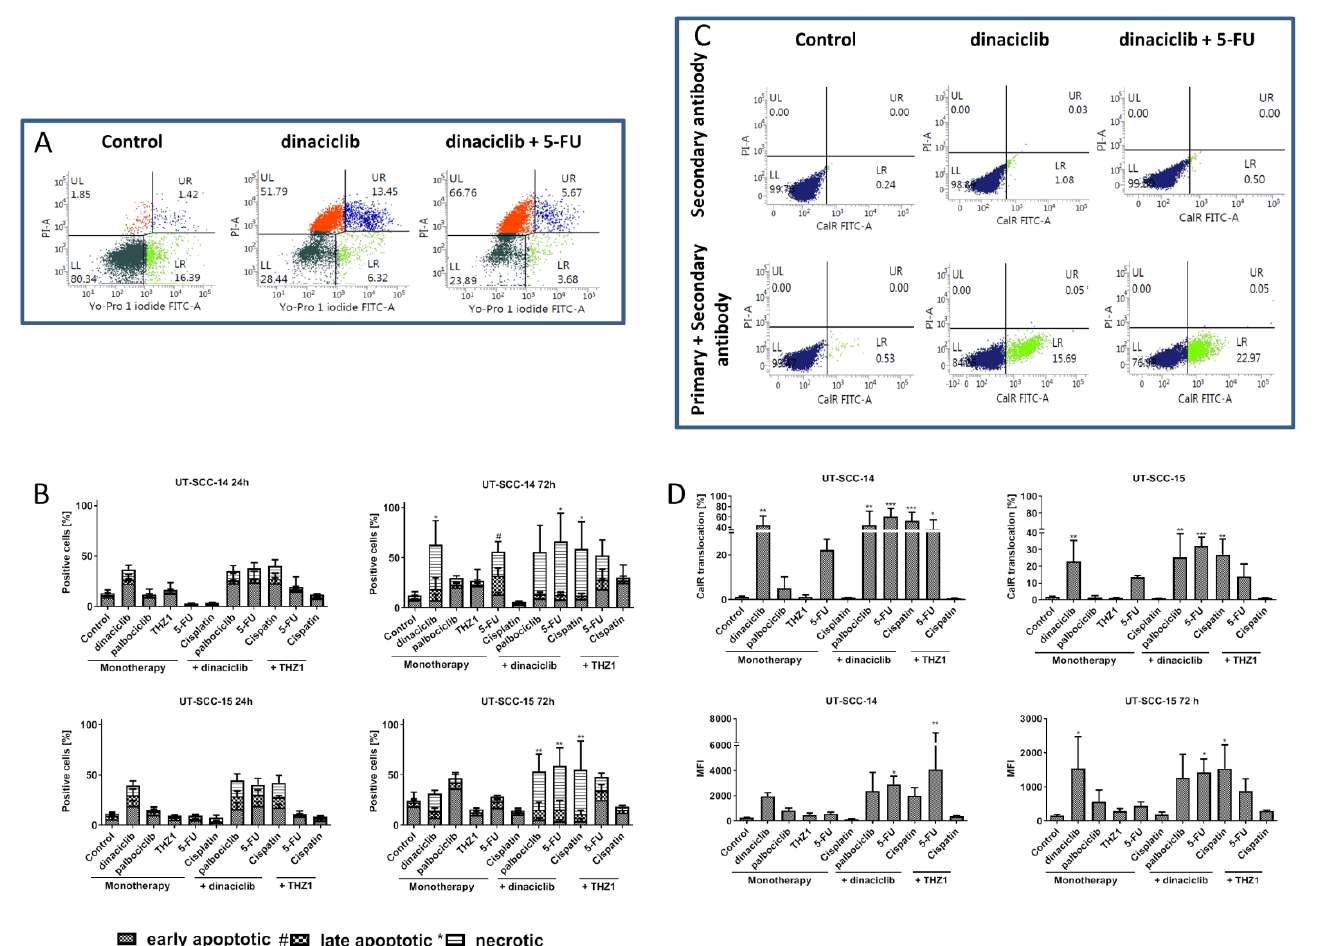
Figure 2. Apoptosis/necrosis assay and detection of immunogenic cell death (ICD). For ( A , B ) apoptosis/necrosis assay, cells were stained with Yo-Pro 1 iodide and PI. Cells that were positive for Yo-Pro 1 iodide were defined as early apoptotic, cells that were positive for PI were defined as necrotic, and double positive cells were defined as late apoptotic. Apopto- sis/necrosis assay was done after 24 h and 72 h. ( A ) Representative dots plots showing distribution of viable and dead cells (either apoptotic or necrotic). ( B ) Quantitative analysis of apoptotic and necrotic cells subdivided into early apoptotic (Yo-Pro1 + /PI − ), late apoptotic (Yo-Pro1 + /PI + ) and necrotic ((Yo-Pro1 − /PI + ). ( C , D )) ICD was detected after 72 h treatment by staining CalR on the cell surface. In both assays, 10,000 events were measured and the percentage of cells showing CalR translocation and the mean fluorescence intensity (MFI) of CalR + cells are provided. Drug doses were as follows: dinaciclib [0.02 µM]; palbociclib [1 µM]; THZ1 [UT-SCC14: 0.02 µM; UT-SCC-15: 0.005 µM]; 5-FU [90 µg/mL]; Cisplatin [0.1 µg/mL].